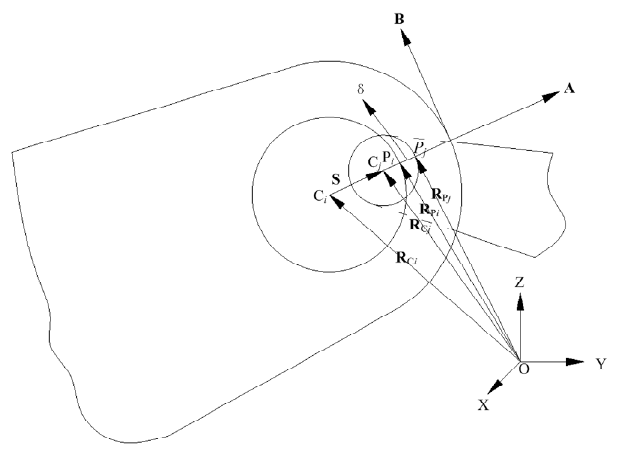
Figure 3. Contact kinematic of joint bearing with clearance.